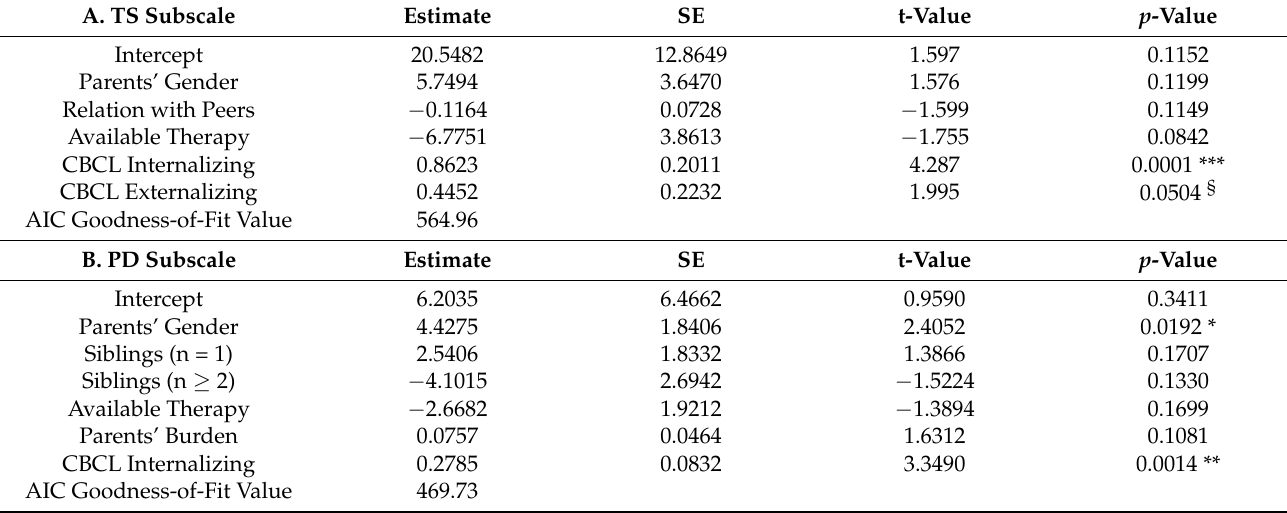
Figure 2. Multiple mediation model on the association between the relationship quality with peers, internalizing and externalizing problems and the PSI-4-SF Difficult Child subscale. The effect of the children’s relationship with peers on the Difficult Child subscale is mediated both via the internalizing and externalizing problems of the child. * p -value < 0.05; *** p -value < 0.001. Table 1. PSI-4-SF questionnaire: backward stepwise generalized linear models.